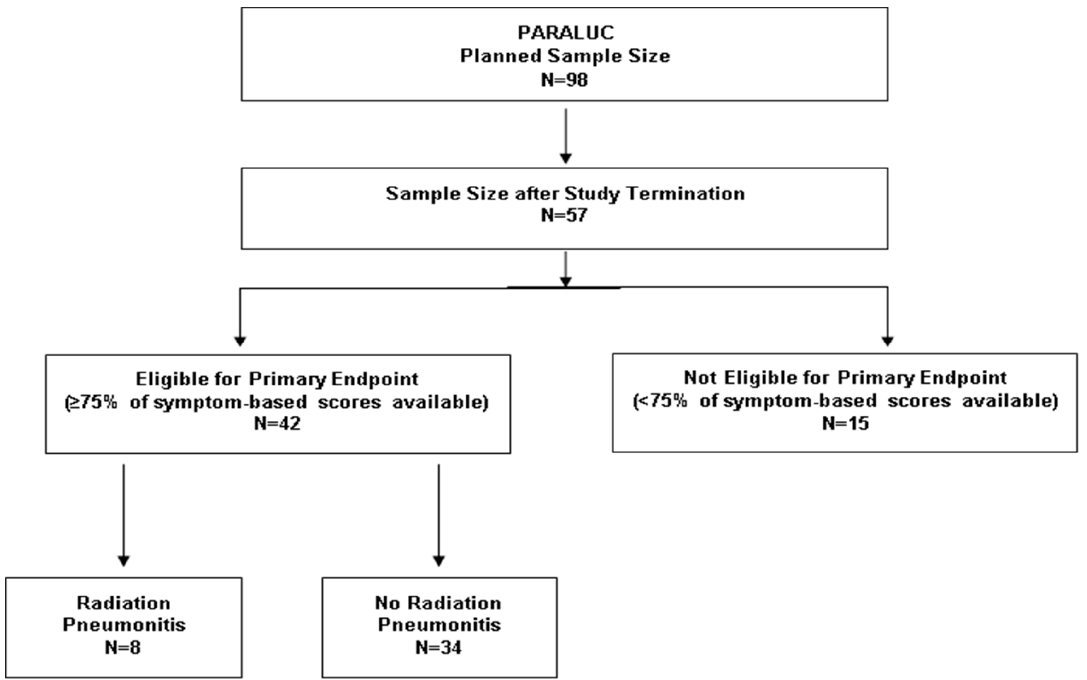
Figure 1. Patient enrollment and eligibility for the primary endpoint (evaluation of the presence or absence of radiation pneumonitis).